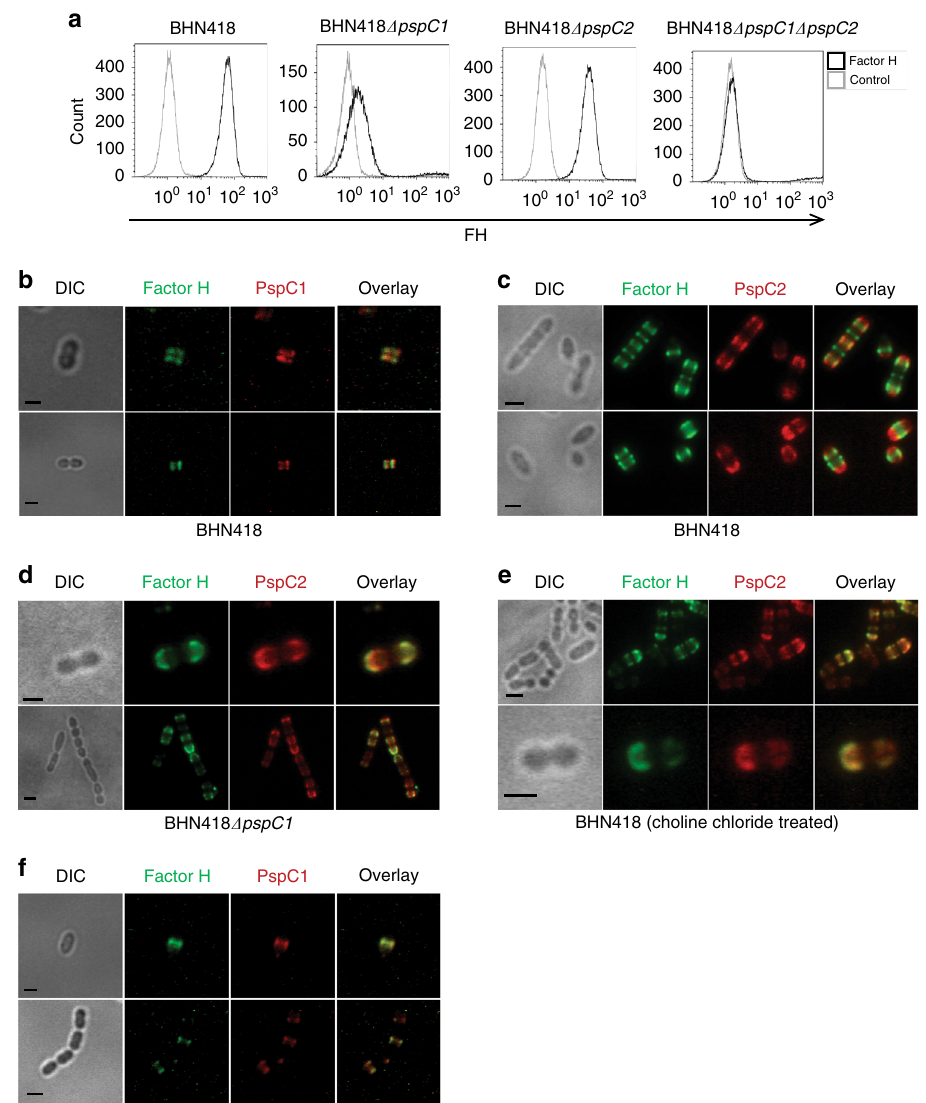
Fig. 4 Even though PspC1 and PspC2 show similar binding strength to FH in vitro, PspC1 is the major contributor to FH recruitment in vivo. a Representative histogram of FH binding to BHN418 and its isogenic pspC deletion mutants using fl ow cytometry. Bacteria were incubated with puri fi ed human FH and stained as in Fig. 3a. Bacteria incubated without FH were used as a control for each strain. The histogram shown is representative of three independent experiments. b BHN418 was incubated with puri fi ed human FH, and FH was detected using a polyclonal goat anti-FH antibody and a FITC-labeled rabbit anti-goat IgG secondary antibody (green). Bacteria were then stained for PspC1 using anti-PspC1 antiserum and anti-mouse Alexa fl our 594 secondary antibody (red). c Strain BHN418 was incubated with puri fi ed human FH, and FH was detected using a polyclonal goat anti-FH antibody and a FITC-labeled rabbit anti-goat IgG secondary antibody (green). Bacteria were then stained for PspC2 using serum puri fi ed rabbit anti-PspC2 polyclonal antibody labeled with Alexa fl uor 594 (red). d The deletion mutant of PspC1, BHN418 Δ pspC1 , was stained for bound FH and PspC2 as in c . e Choline chloride treated BHN418 bacteria were incubated with puri fi ed human FH. FH and PspC2 were stained as in c . f The mutant strain BHN418 Δ pspC2 was stained for bound FH and PspC1 as in b . b – f Scale bar = 1 µ